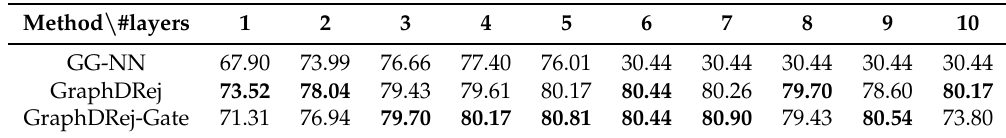
Table 4. Rejection mechanism vs. gate mechanism. We report the accuracy (%) of nodes classification with different numbers of layers on Cora.